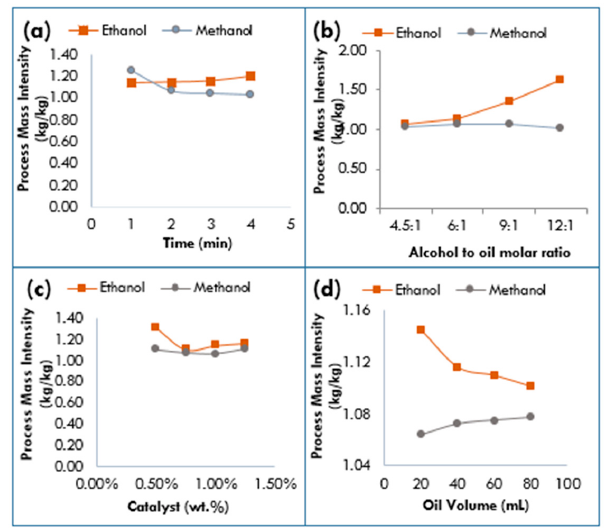
Figure 4. Mass Intensity results for the simultaneous effect of MW/US in WCO transesterification. Effect of ( a ) different reaction time; ( b ) alcohol to oil molar ratio; ( c ) catalyst concentration and ( d ) sample (oil) volume.